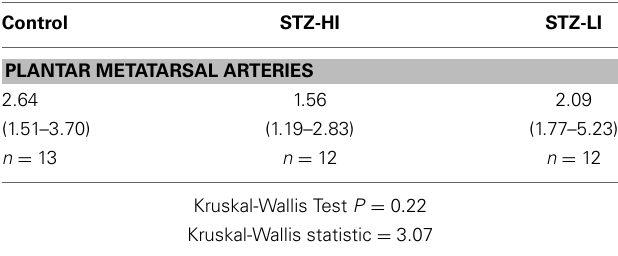
Table 2 | Comparison of β -actin protein expression levels (relative to the internal standard) in arterial samples from control rats and streptozotocin (STZ)-treated rats receiving a high (STZ-HI) or low dose of insulin